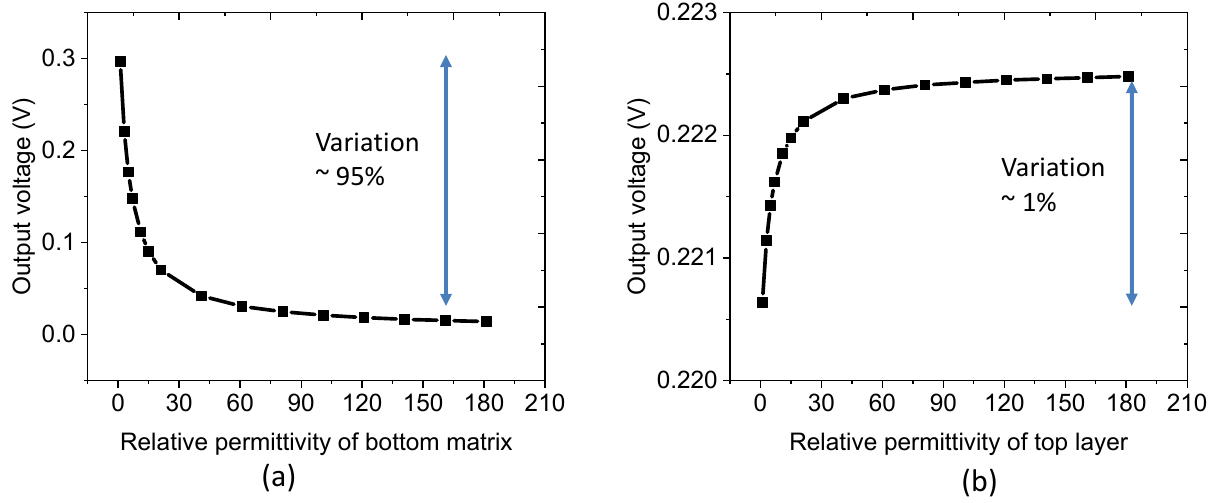
Figure 7. Effect of relative permittivity of the ( a ) bottom matrix layer, ( b ) top layer on the generated output voltage.